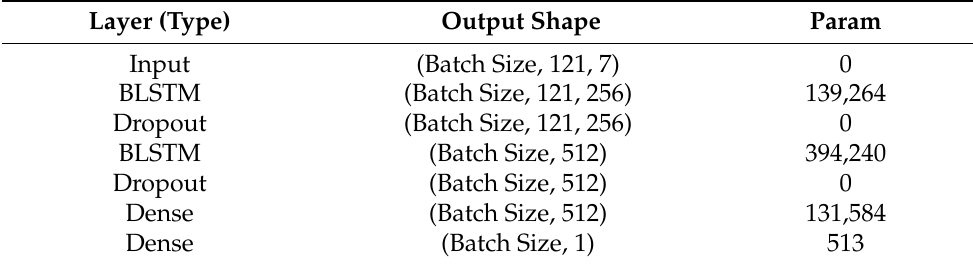
Table 6. BLSTM architecture used to predict potato yield.